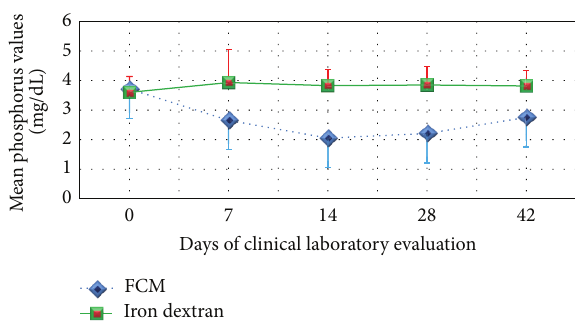
Figure 2: Mean phosphorus values for FCM and DEX patients.